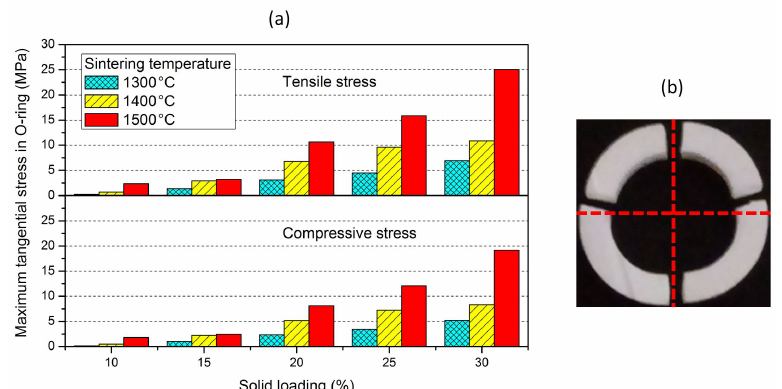
Figure 4. Tangential stress distribution in the tube with 20% solid loading and sintered at 1500 °C under maximum loading in the O-ring test.